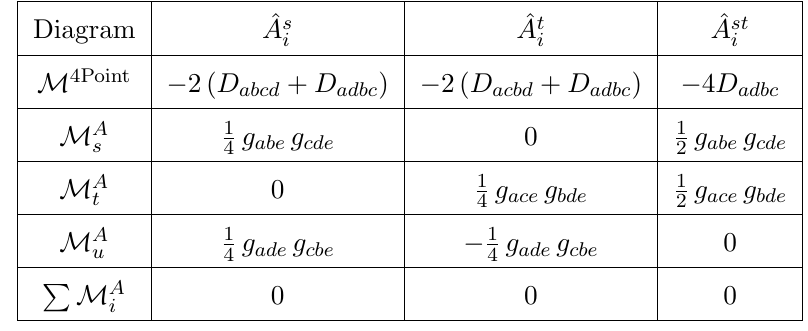
Table 5 . Coe(cid:14)cients ^ A i